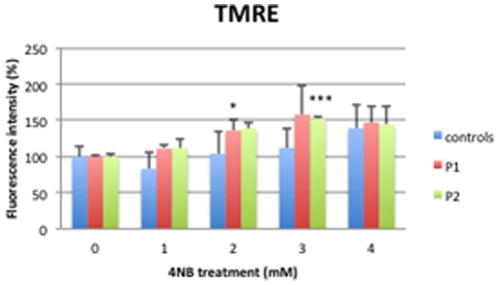
Assessment of mitochondrial membrane potential with TMRE in control (n = 5), P1 and P2 skin fibroblasts after 4-NB treatment.The values are expressed as percentage of controls, P1 and P2 after 4 mM DMSO treatment. (* P<0.05 vs. controls;***P<0.001 vs. controls).